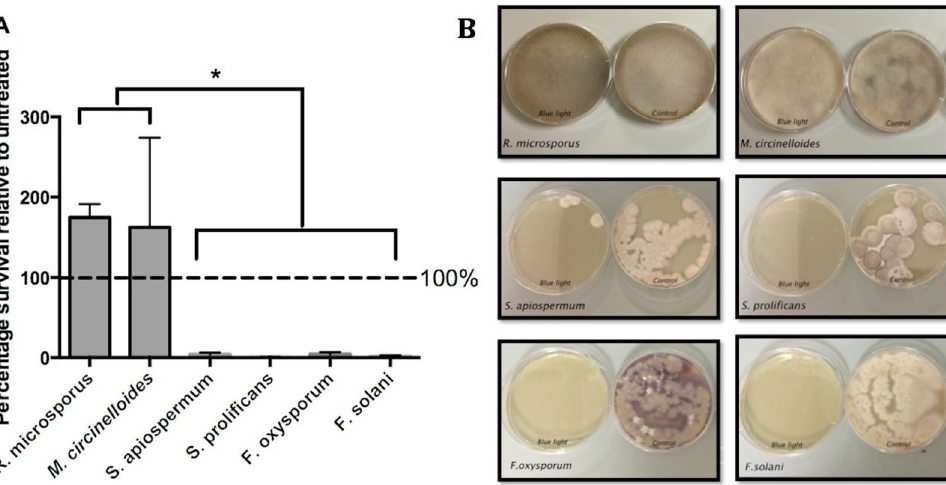
Figure 1. 60 min (216J/cm 2 ) blue light treatment of fungal spores. Spores were inoculated in PBS treated with blue light and then plated onto appropriate agar plates for enumeration ( A ). Alternatively, 1000 spores were plated onto agar and then exposed to blue light for 60 minutes before being incubated for growth ( B ) Error bars represent standard deviation (n = 3, with three experimental replicates) One-way ANOVA followed by Tukey’s multiple comparisons test shows significant difference (p < 0.05 for all comparisons) in blue light treatment survival between R . microsporus and M . circinelloides and other species tested. ( B ) represent images of fungal growth on agar plates following blue light